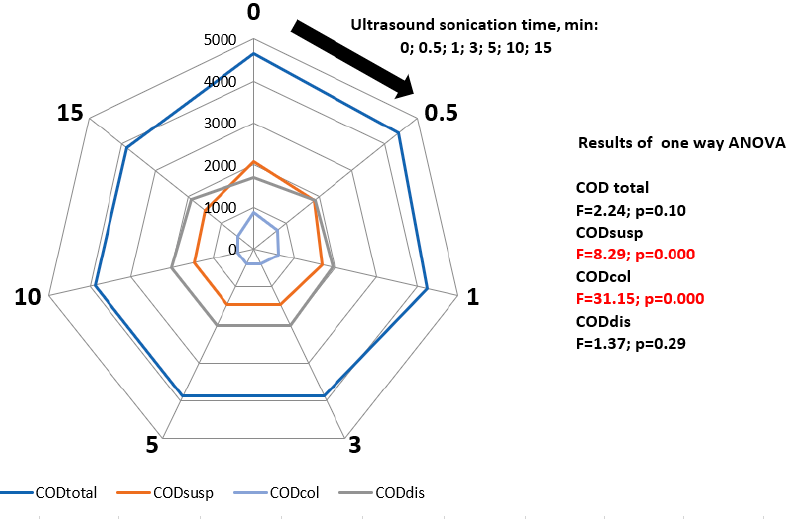
Table 3. Results of Tukey HSD test for BOD 5 ; BOD 5 /COD and pH—impact of sonication time on the indicated parameters (cells marked with stars and same letters in the table are not significantly different according to the carried out Tukey test ( p > 0.05).